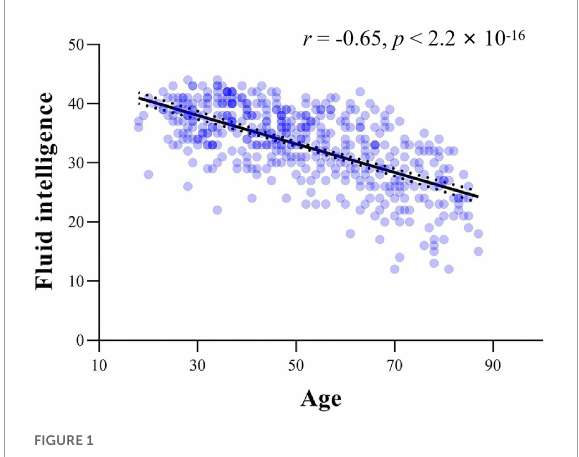
FIGURE1 The scatter plot between age and fluid